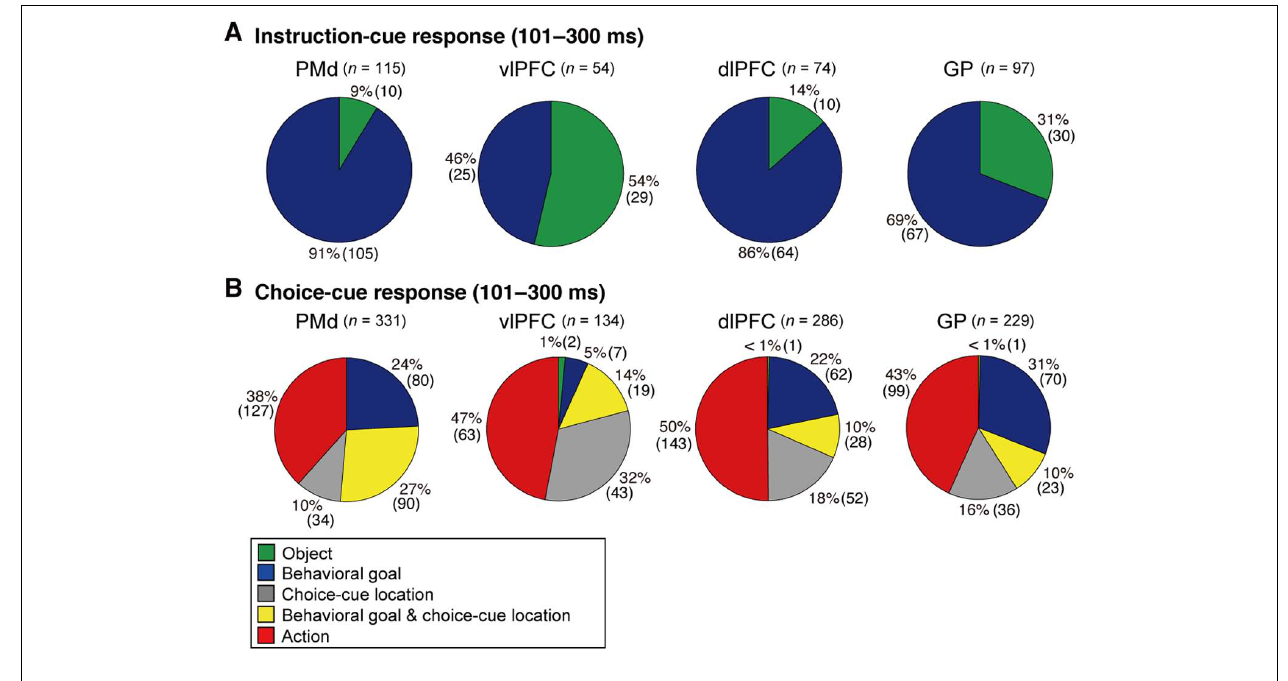
FIGURE 8 | Distribution of selective neurons in the PMd, vlPFC, dlPFC, and GP. Pie charts summarize the proportion of neurons classified into five categories.Two sets of data are shown for 101–300 ms after the onset of instruction cue (A) and 101–300 ms after the onset of the choice cue (B) . Each